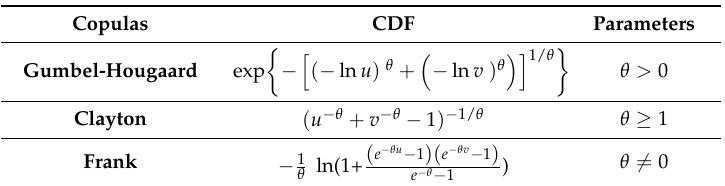
Table 1. 2D Archimedean Copula